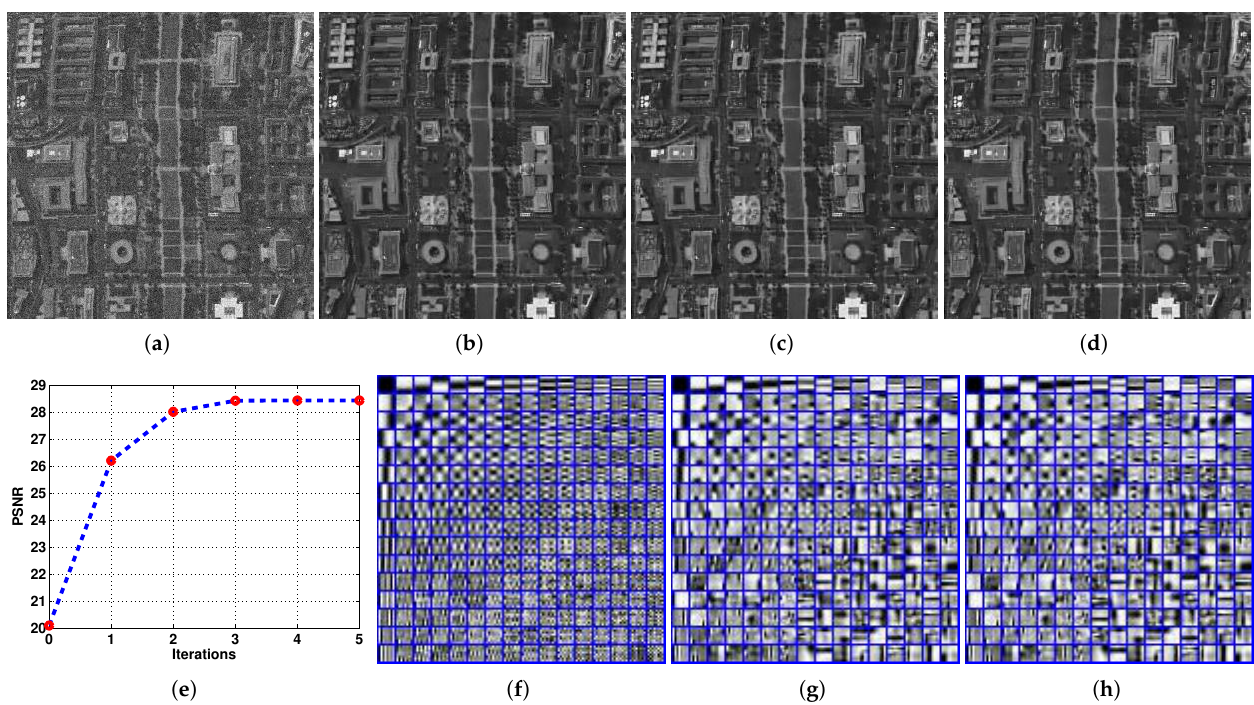
Figure 6. The convergence curve and intermediate results generated by the proposed MD 3 method. ( a ) Noised ( σ = 20). ( b ) x 1 , PSNR: 26.21 dB. ( c ) x 3 , PSNR: 28.43 dB. ( d ) x 5 , PSNR: 28.44 dB. ( e ) Con- vergence. ( f ) D 1 . ( g ) D 3 . ( h ) D 5